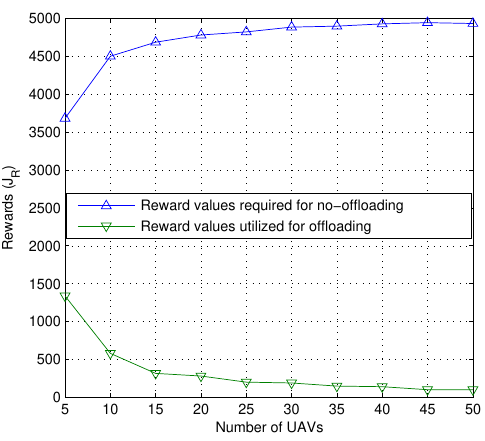
Figure 7. Rewards vs. number of UAVs.